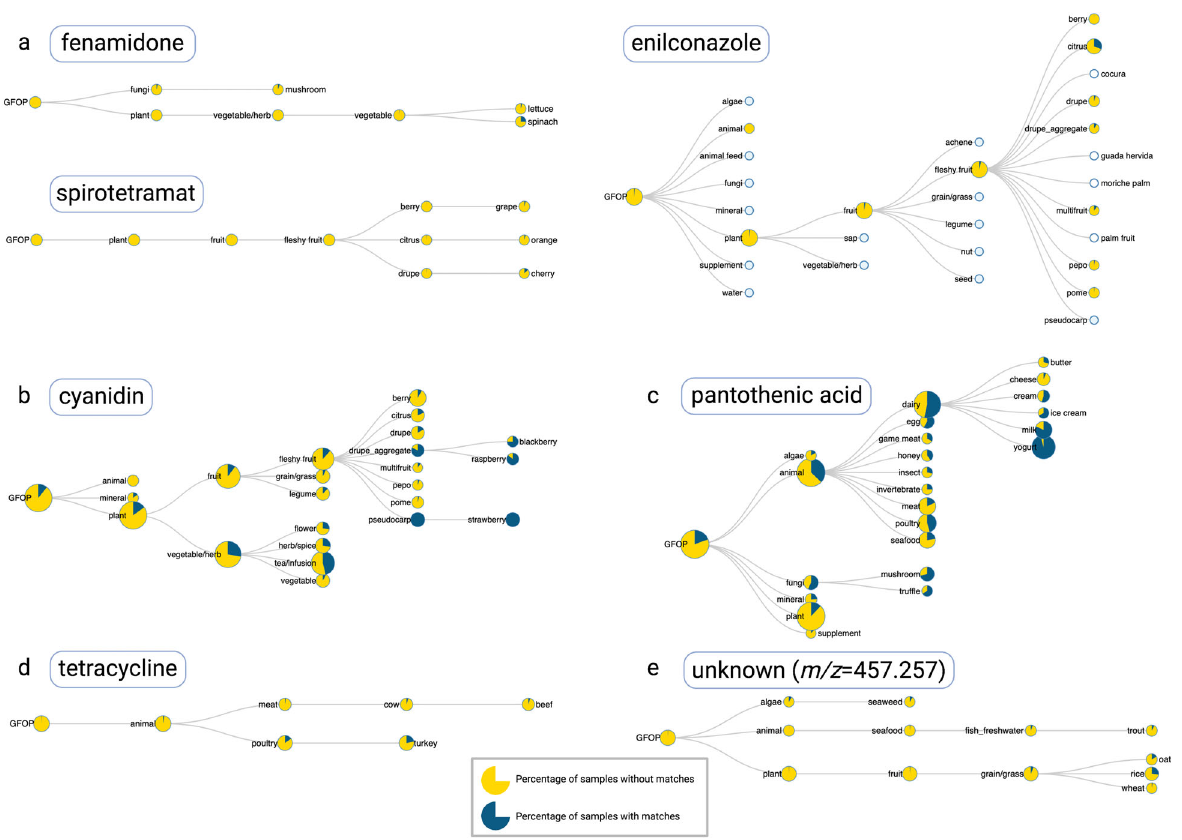
Fig. 2 Examples of foodMASST results. a Three biocides were queried against the Global FoodOmics reference dataset to determine their presence among sampled foods. b Cyanidin, a plant pigment responsible for reddish-purple color, was observed in the expected categories such as teas, blackberries, raspberries, and strawberries. c Vitamin B 5 was observed across many food categories but was most prevalent in animal and fungi samples. d Tetracycline, an antibiotic commonly administered to livestock, was detected only in beef and turkey samples. e An unknown molecule detected in biospecimens from Alzheimer ’ s patients may be related to the consumption of oats or rice. Nodes are scaled according to the total number of samples classi fi ed for that ontology term or any of its descendants. Pies represent the percentages of samples with (blue) and without (yellow) matches to the query